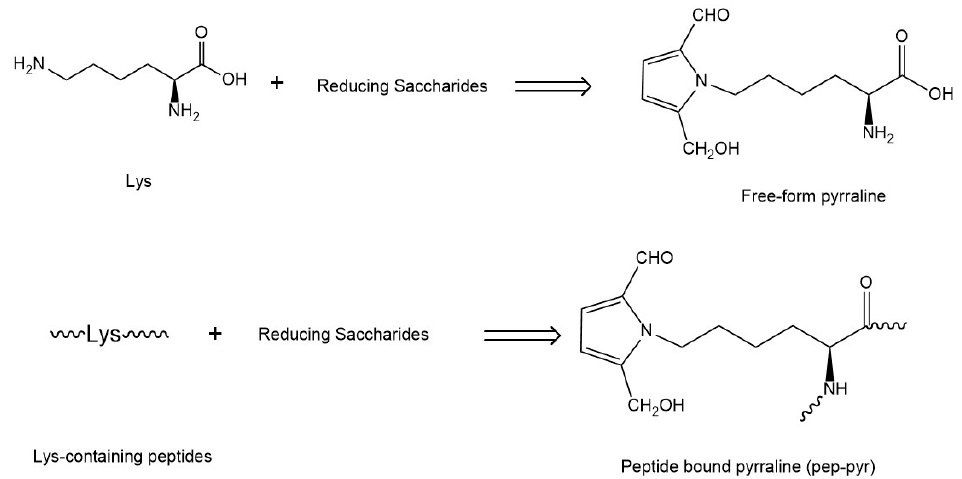
Figure 1. Derivatization of 3-deoxyglucosone (3-DG) by o -phenylenediamine (OPD).